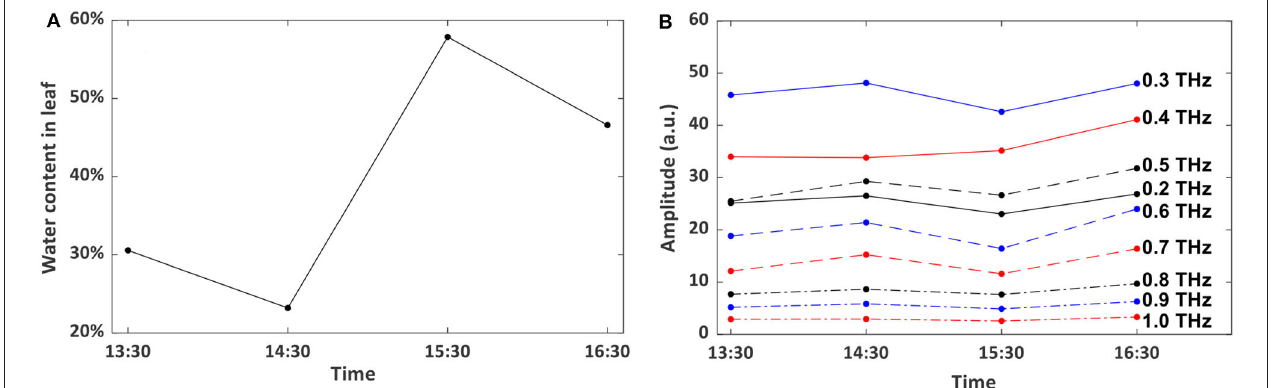
FIGURE 5 | (A) Water content and (B) transmission amplitude of imaging signal after